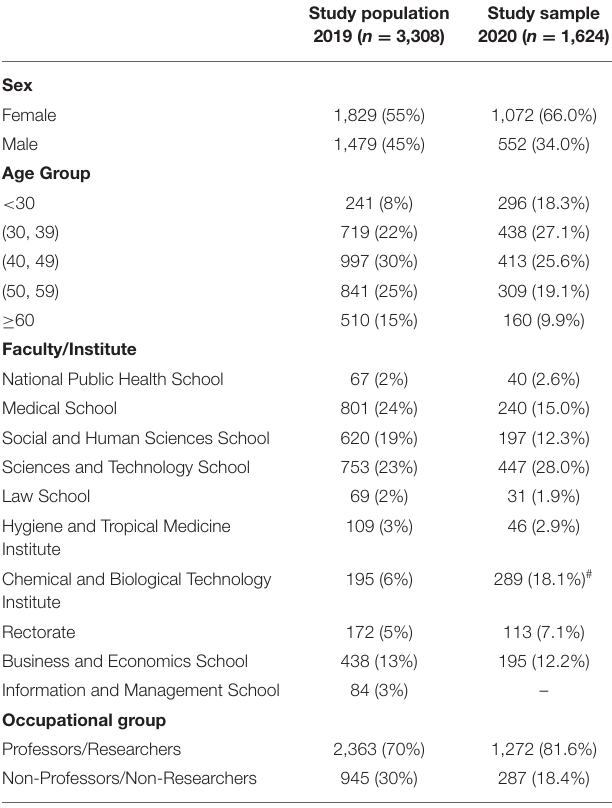
TABLE 1 | Characterisation of NOVA University